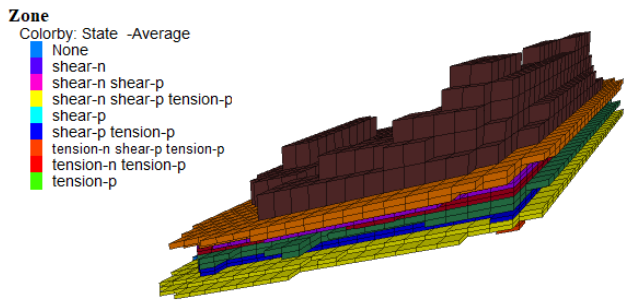
Figure 9. Water storage location obtained by numerical simulation.